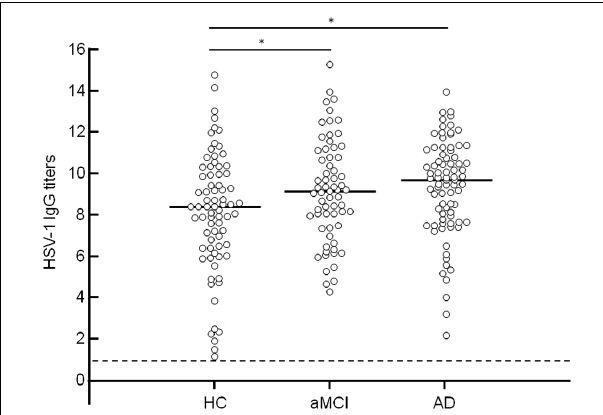
FIGURE 2 |Anti HSV-1 antibody (Ab) titers in healthy control, aMCI, andAD groups. Horizontal lines represent the median value. Dotted line represents threshold value of HSV-1 seropositivity. Statistical significance was evaluated using One-way ANOVA with Bonferroni correction for multiple comparisons (significance level: p corr < 0.05). *Significant compared to aMCI and AD group vs. HC.